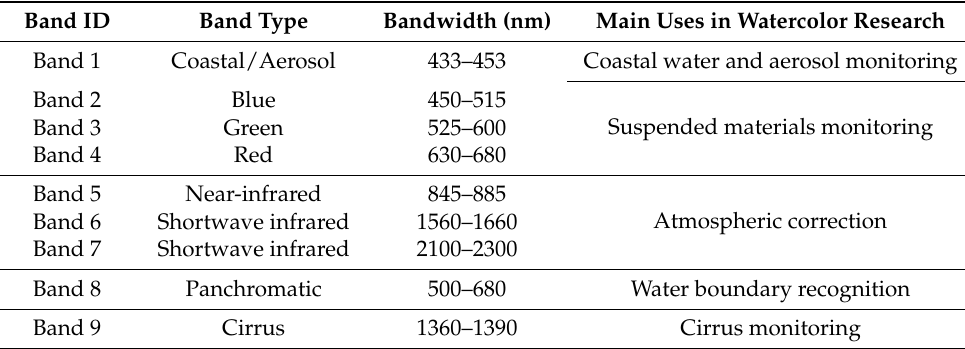
Table 2. Detailed settings about the multispectral bands of the OLI